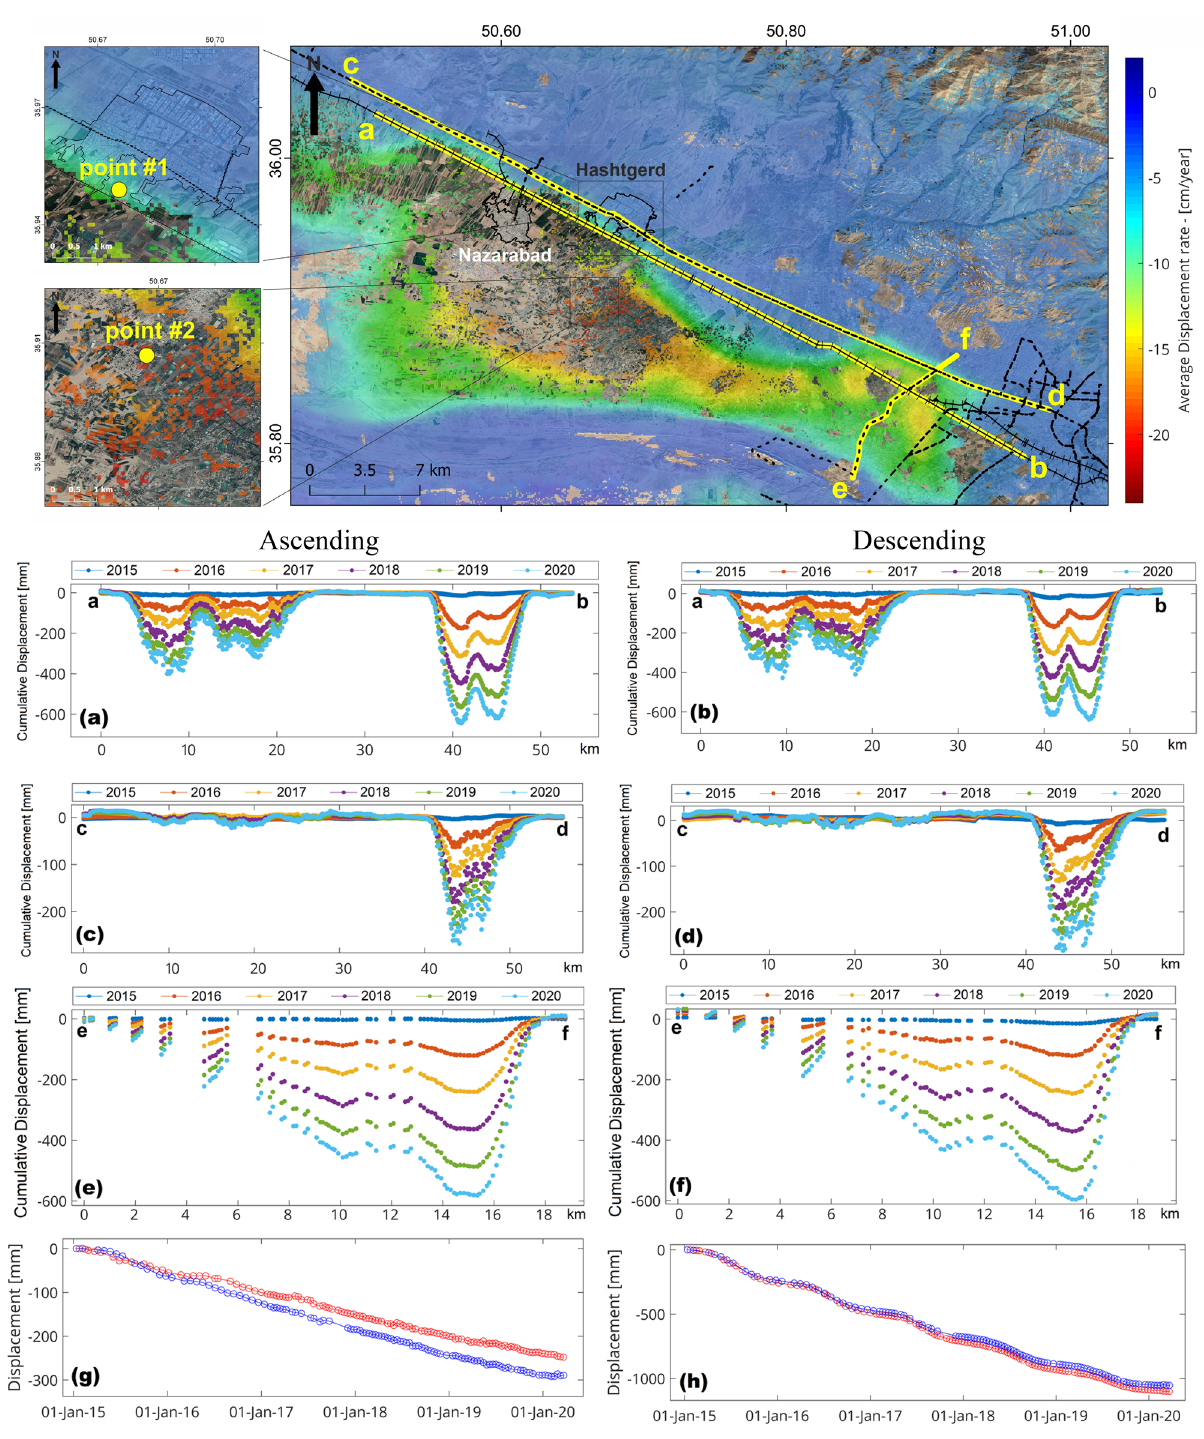
Figure 10. InSAR cumulative displacement for profiles of ( a , b ) railway, ( c , d ) Karaj-Hashtgerd highway, and ( e , f ) profiles crossing the railway and highway, ( g ) a point to the south of Hashtgerd, and ( h ) a point in the area of maximum subsidence in Hashtgerd plain. This figure was created using the QGIS version Desktop 3.18.1 software (https:// qgis. org/ en/